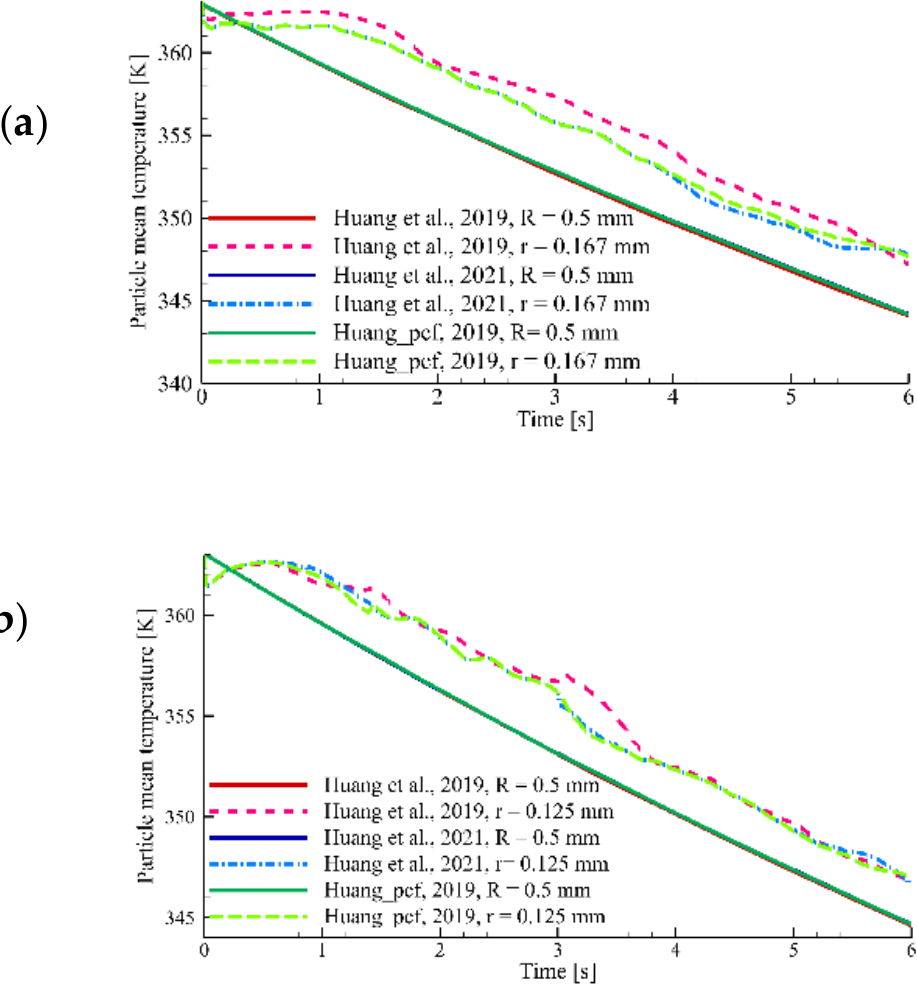
Figure 8. Variation in particle mean temperature at different particle diameter ratios between large and small particles: ( a ) 3:1; ( b ) 4:1. Huang et al., 2019 [9], Huang et al., 2021